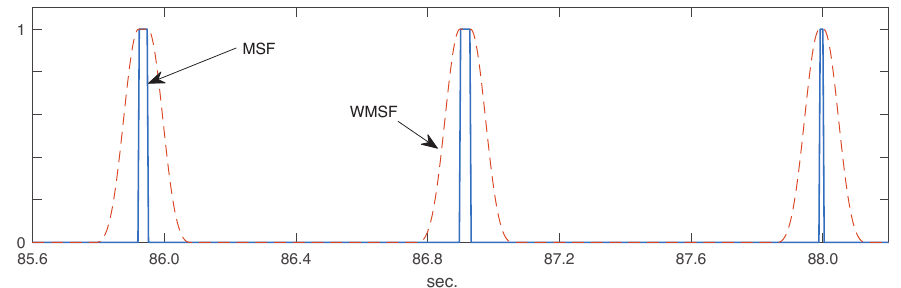
Figure 6. A piece of a MSF and its corresponding